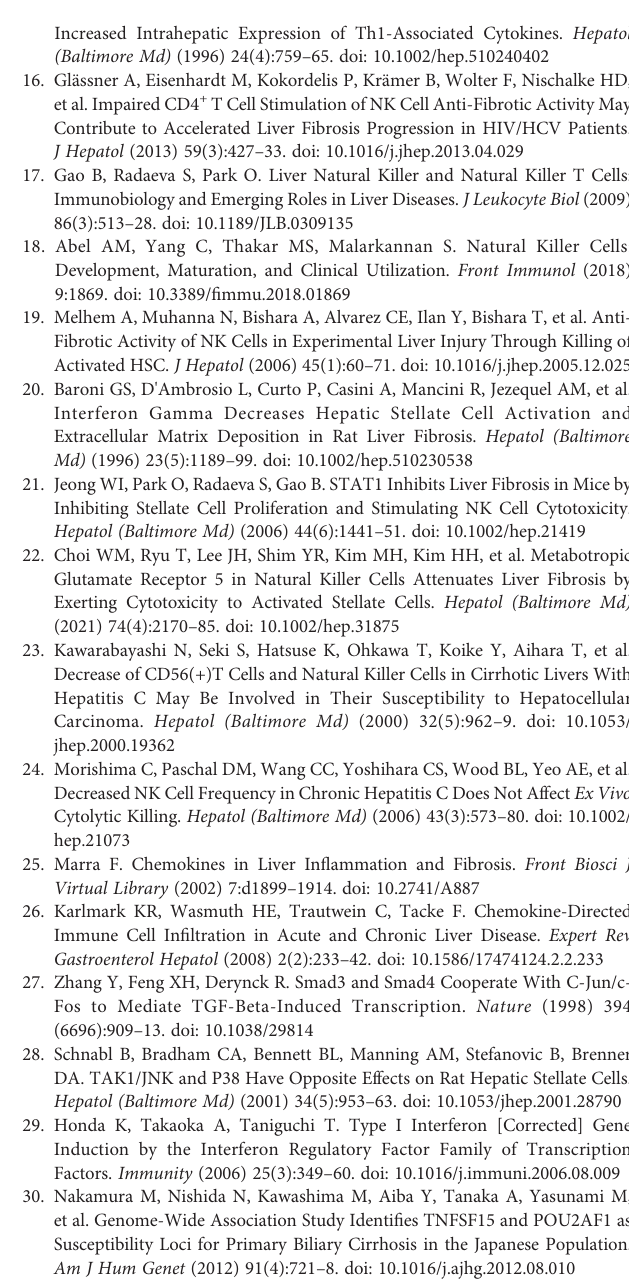
Supplementary Figure 1 | Gene expression levels of IRGs (FYN, IFNG, KLRD1, and HLA-G) on t-SNE plots between the healthy group and the cirrhotic group. Red coloration indicates the expression of the genes. Supplementary Figure 2 | Gene expression levels of TFs (ID2, ETS1, IRF1, and PRDM1) on t-SNE plots between the healthy group and the cirrhotic group. Red coloration indicates the expression of the genes. Supplementary Table 1 | IRGs of liver cirrhosis from GSE136103 dataset. Supplementary Table 2 | DEG of liver cirrhosis from GSE45050 dataset. Supplementary Table 3 | IRGs of liver cirrhosis from GSE45050